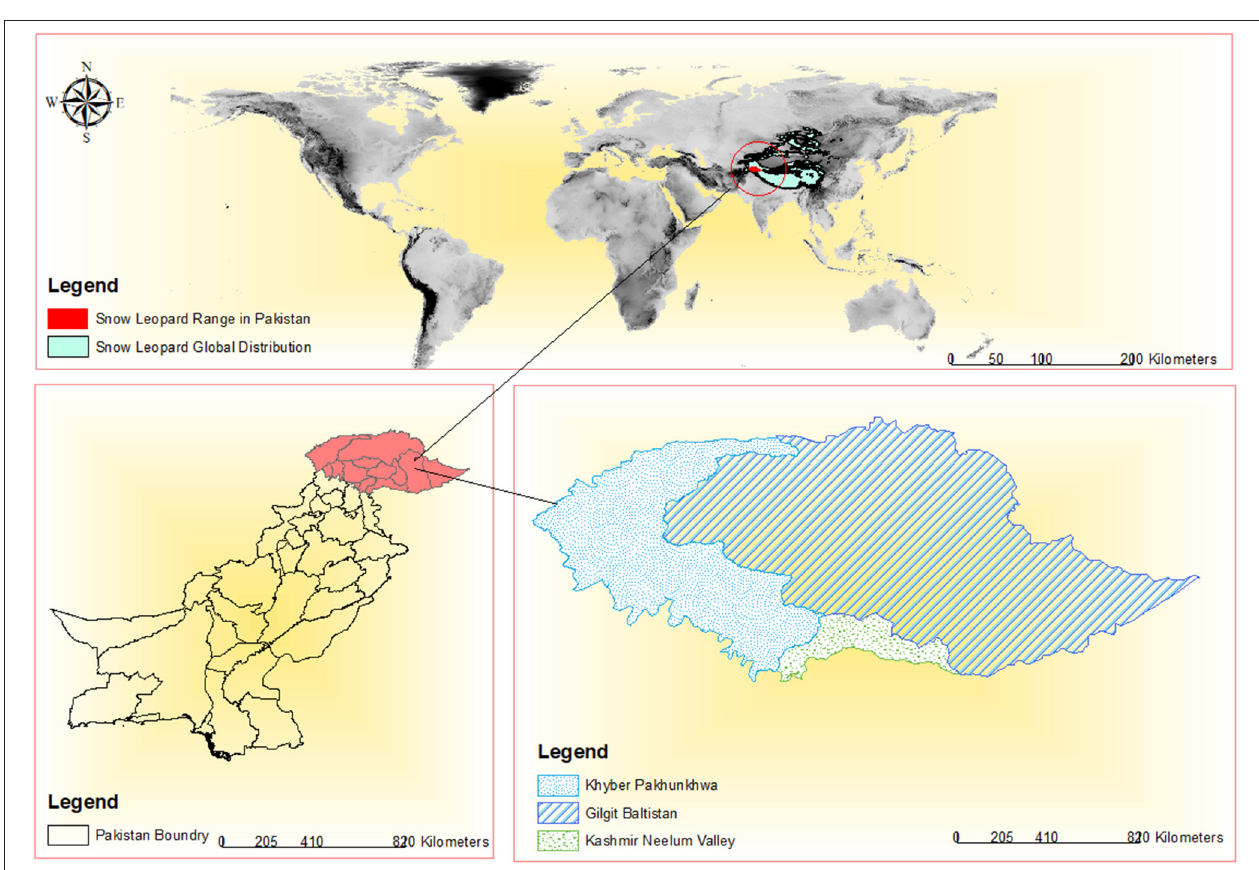
FIGURE 2 | Snow leopard distribution range in Pakistan